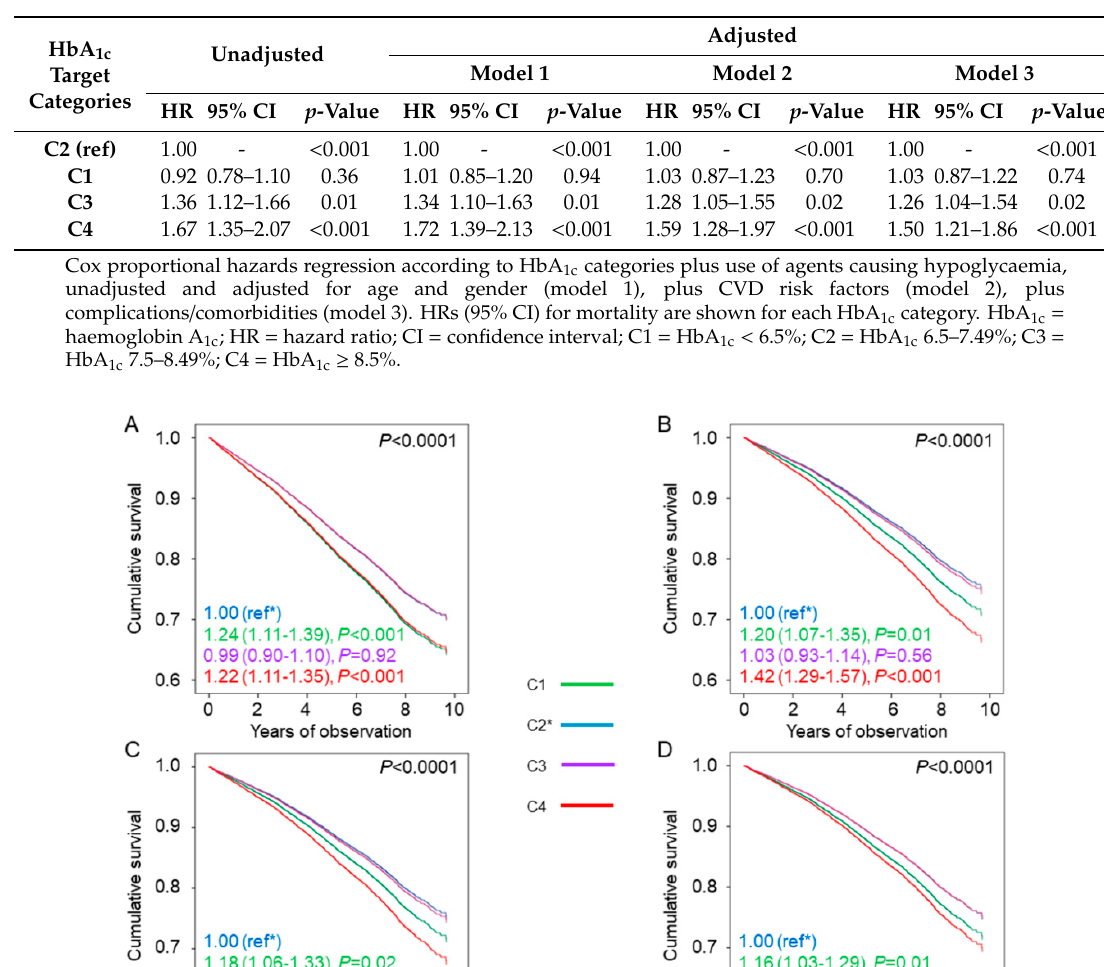
Table 2. Mortality risk by HbA 1c categories among participants not treated with agents causing hypoglycaemia.